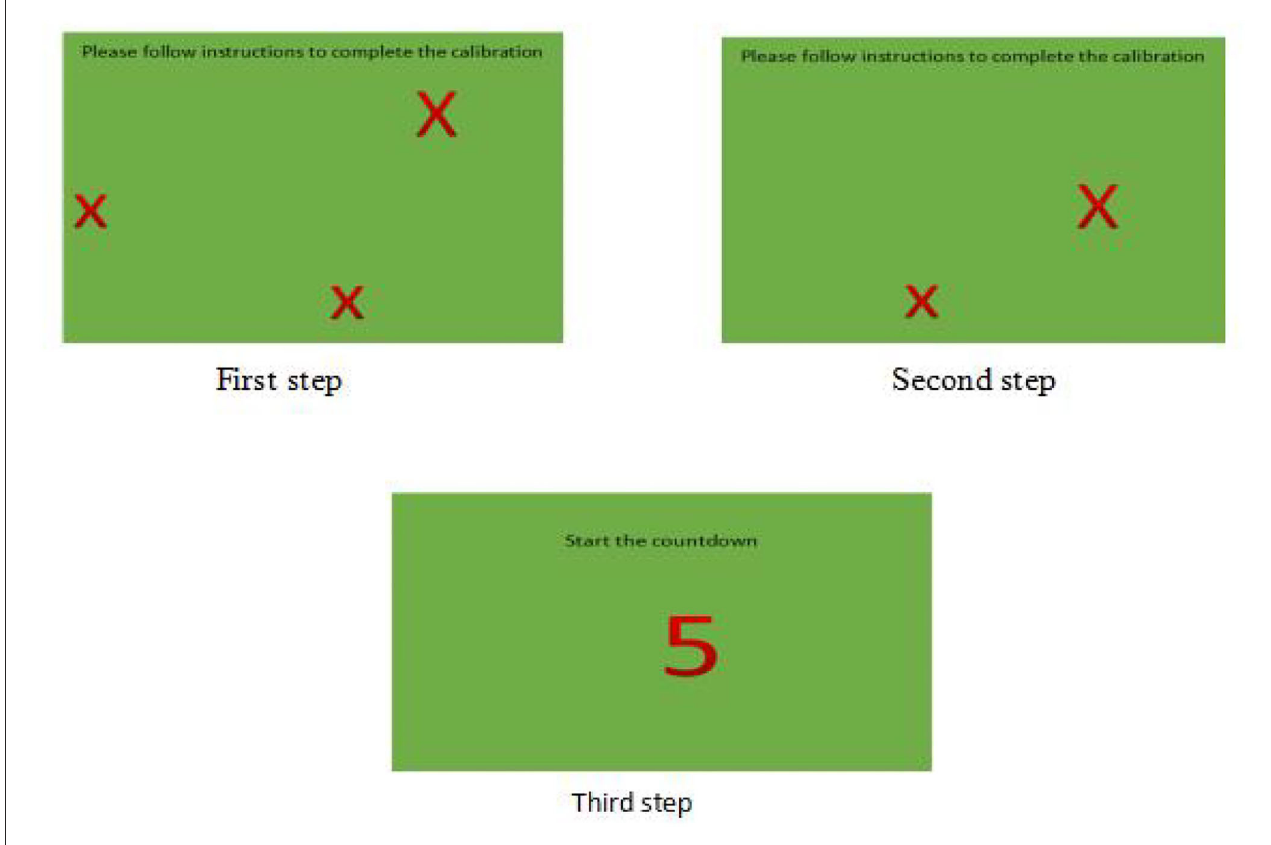
FIGURE3 Instrument calibration procedure before the